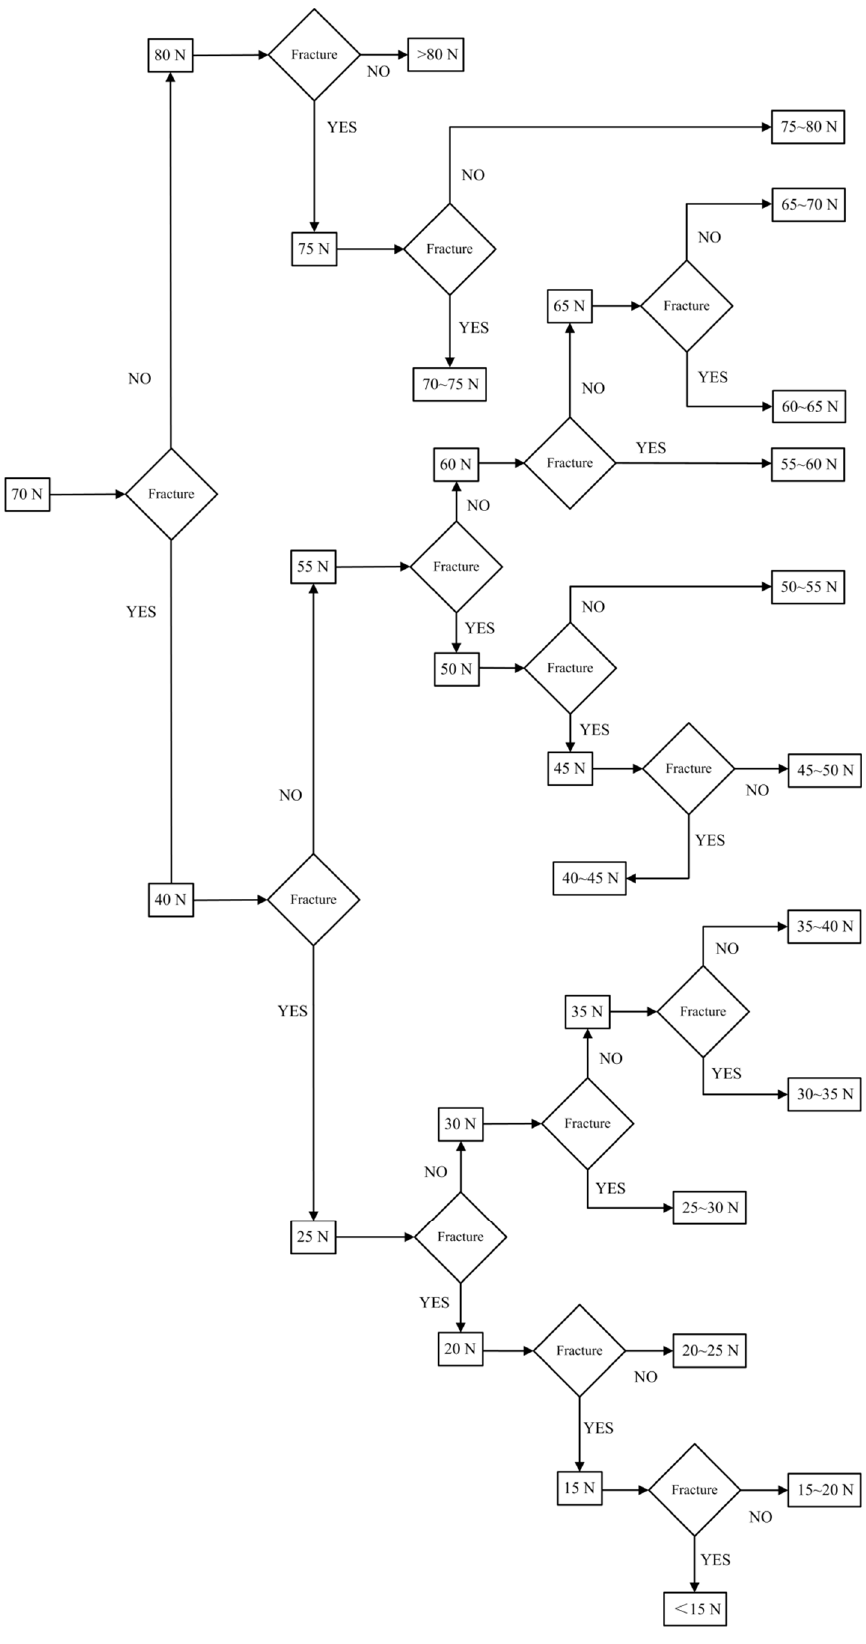
Figure 19. Test scheme of shear pin.